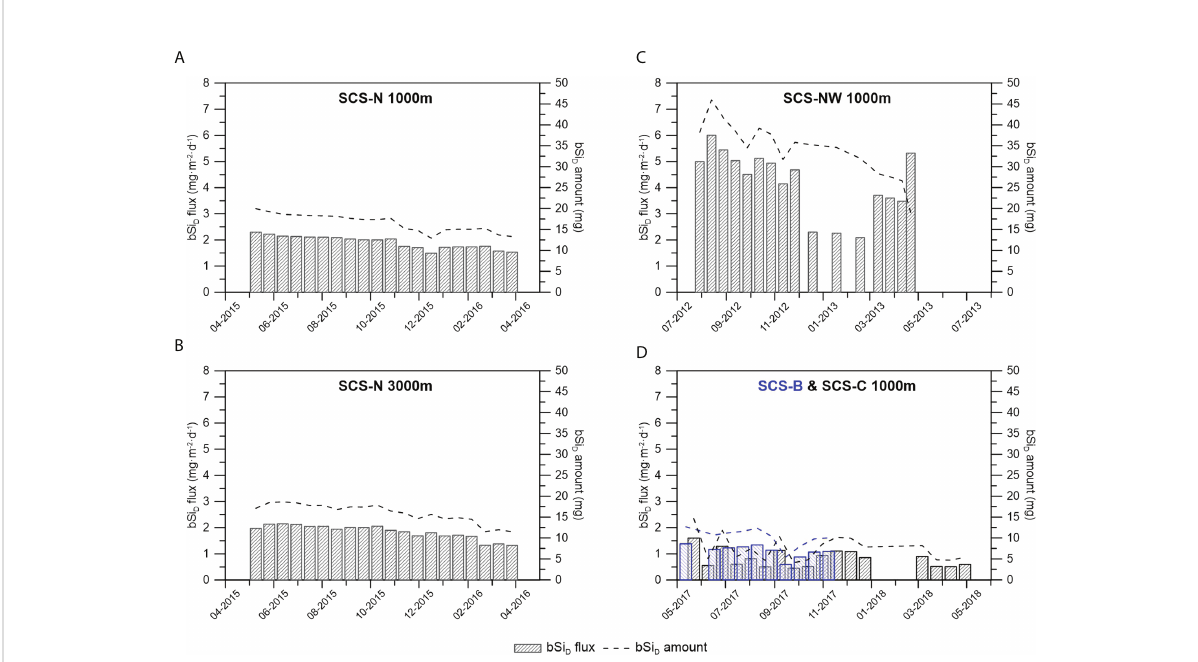
FIGURE 3 The bSi D fl ux and amount calculated based on the silicate concentration in the sediment trap sampling bottles at 1000 m of station SCS-N (A) , 3000 m of station SCS-N (B) , 1000 m of station SCS-NW (C) and 1000 m of station B & C with the blueish bars and blueish dotted line representing the data of SCS-B (D)